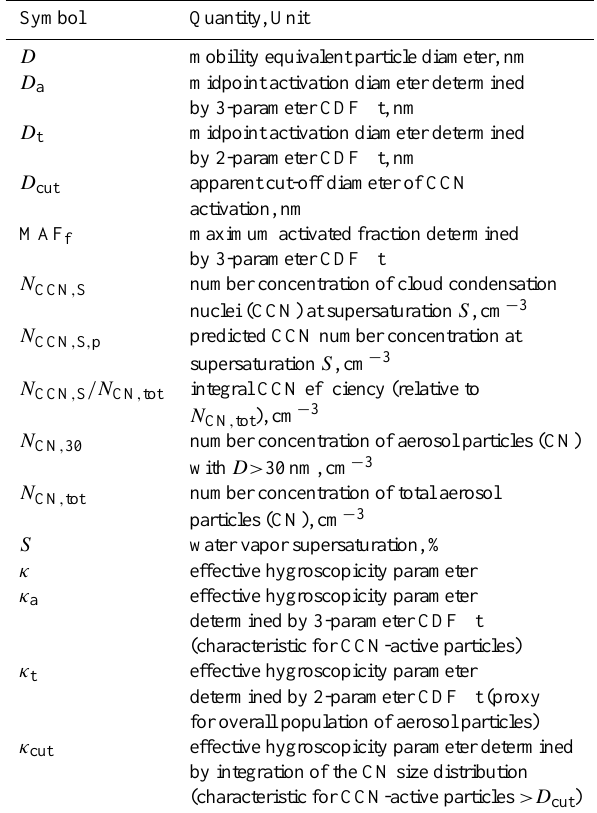
Table A1. Notation (Frequently used